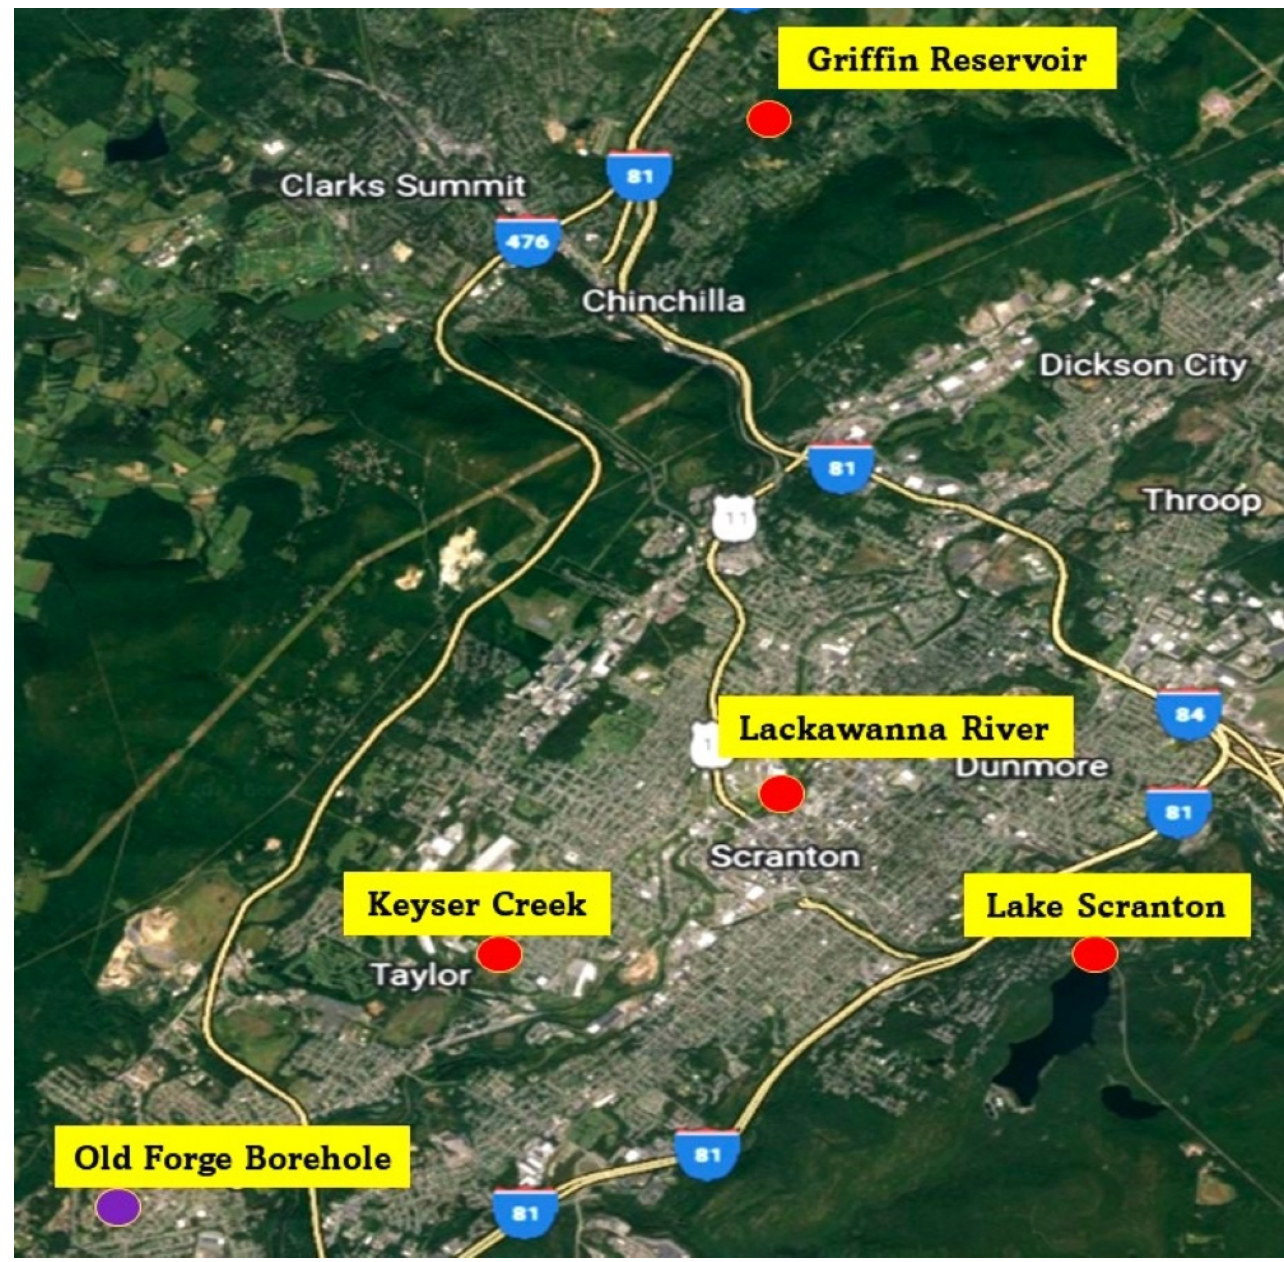
Figure 3. Map Showing the Location of the Old Forge Borehole (purple) in relation to the previous sites mentioned (red).